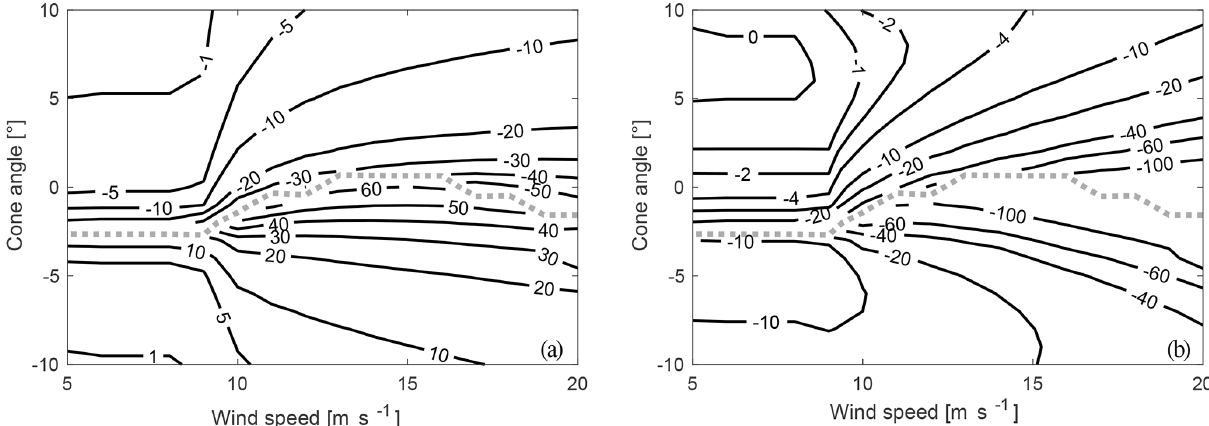
Figure 8. Equilibrium yaw angle ( ◦ ) (a) and the relative difference in power production (%) (b) depending on cone angle and wind speed variation for a turbine configuration with 5 ◦ tilt. The figure is stitched together from two sub-figures at the grey